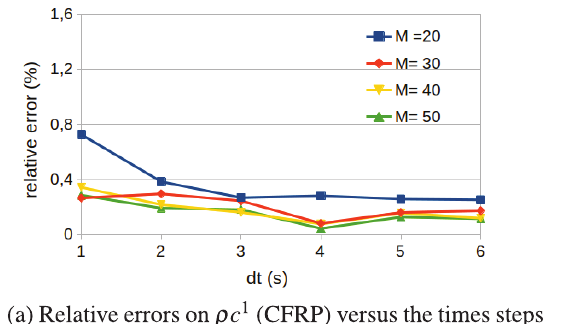
Fig. 9. Relative errors on the ρc with noise ( σ = 0 . 4 ◦ C) on the temperature fields for CRFP-PA material for several times